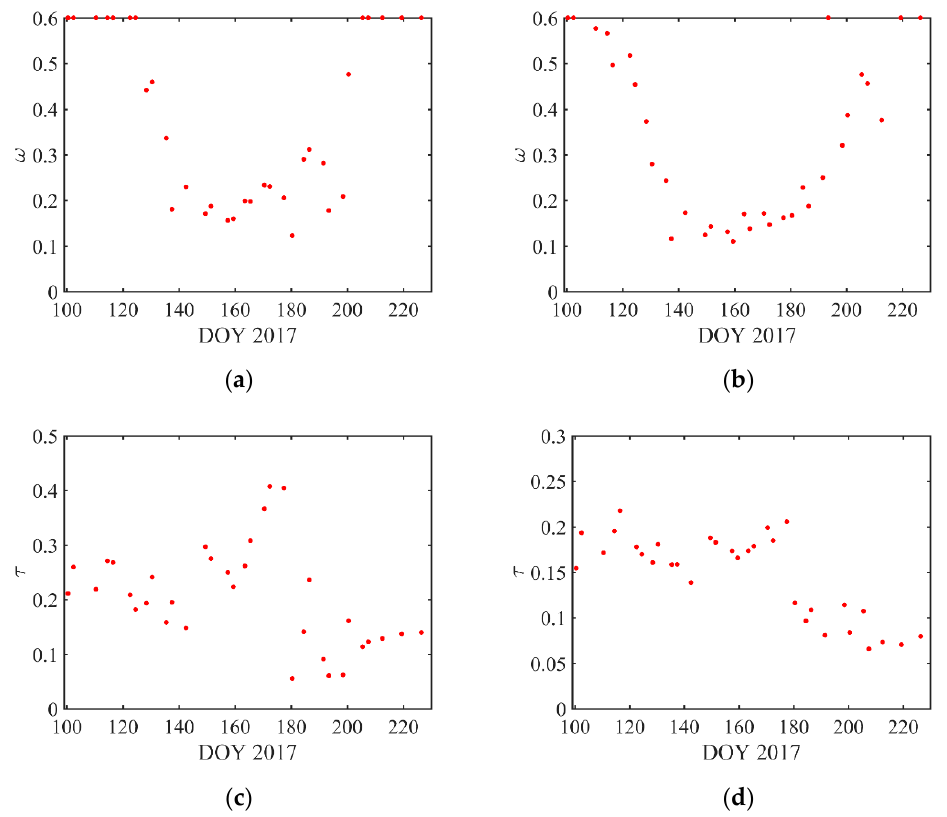
Figure 12. Retrieved effective scattering albedo ( ω ) (i.e., polarization and incidence angle independent) using the 2.1-P retrieval scheme for the single-angle approach ( a ) and the multi-angle approach ( b ), respectively, and retrieved vegetation optical depth ( τ ) (i.e., polarization and incidence angle independent) using the 2.2-P retrieval scheme for the single-angle approach ( c ) and the multi-angle approach ( d ), respectively.